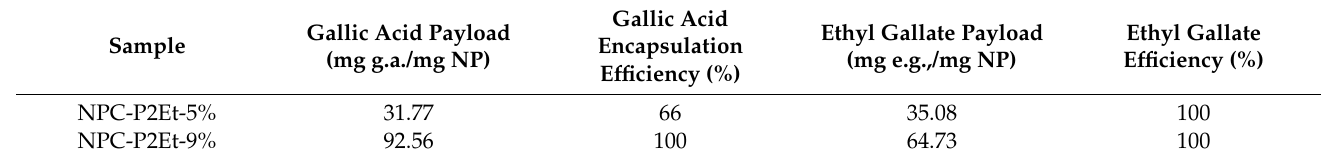
Table 3. P2Et concentration into nanoparticles. The concentration of P2Et entrapped into nanoparti- cles is based on the quantification of two different molecules: gallic acid and ethyl